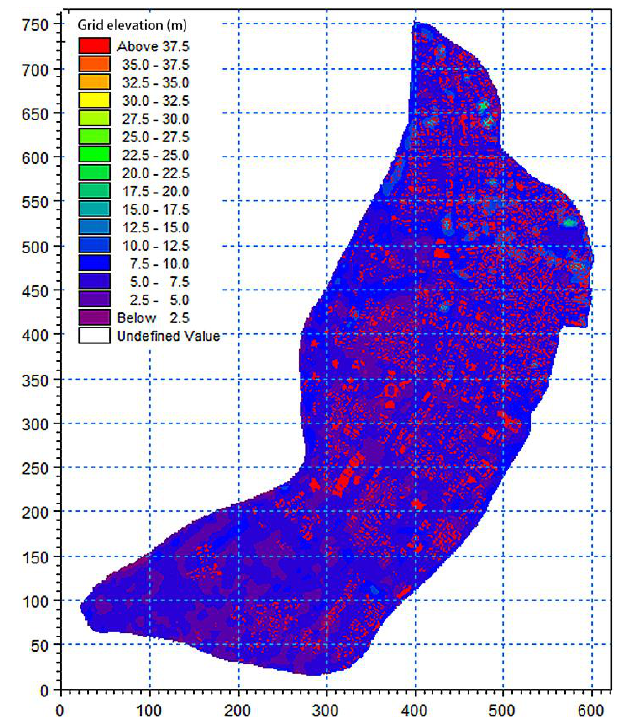
Figure 3. Terrain distribution map of study area.